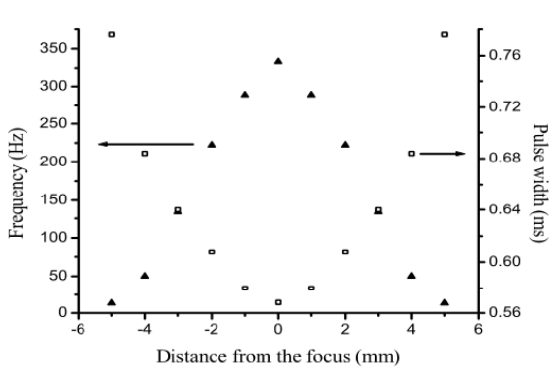
stands M and P are c 